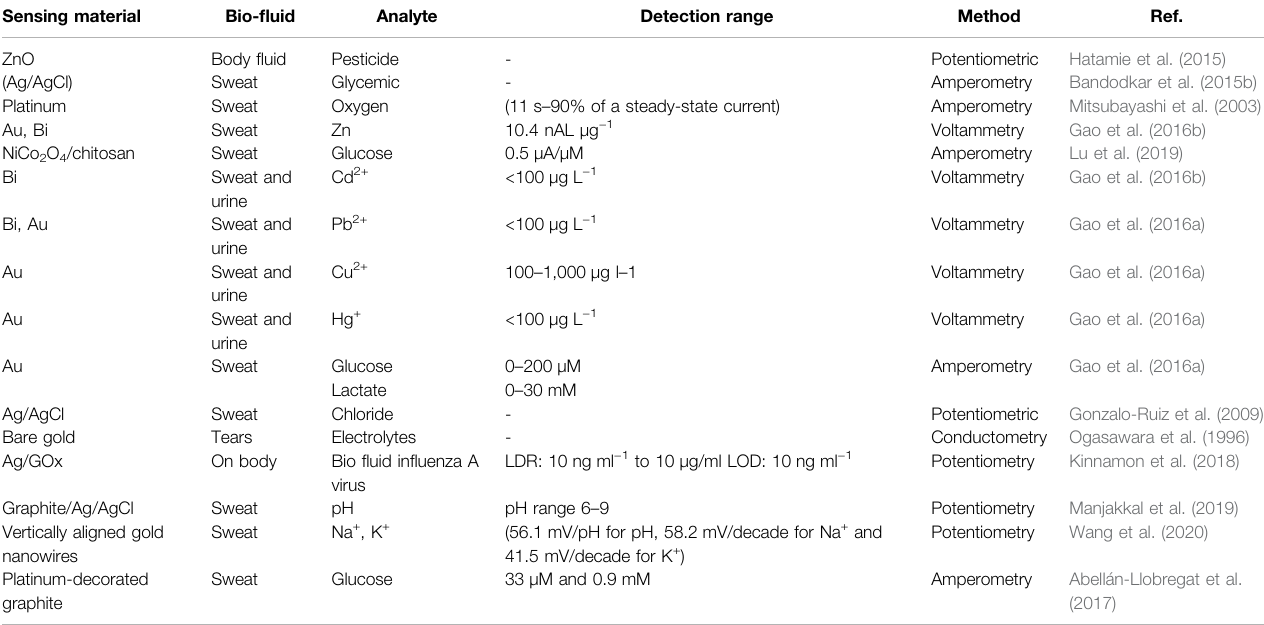
TABLE 3 | Metal based nanomaterials in electrochemical biosensors. Sensing